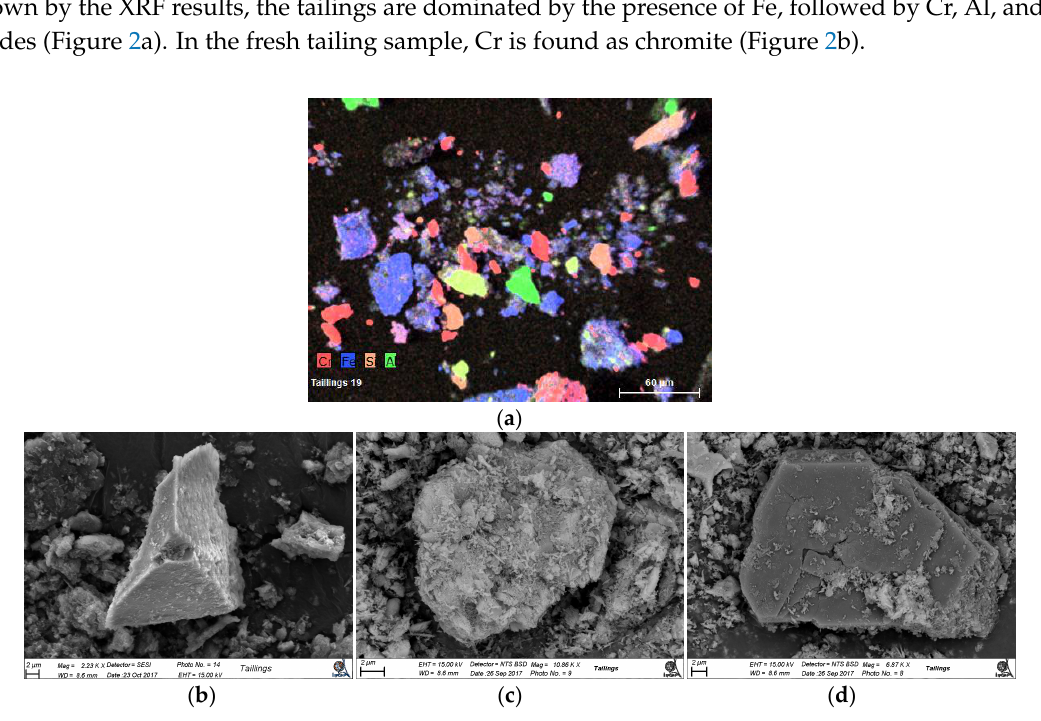
Figure 2. Chromite tailing ( a ) elementary map of EDS showing the dominance of Cr, Fe, Si, and Al. SEM images of ( b ) chromite (Cr 63 wt %), ( c ) iron oxide (Cr 9 wt %), and ( d ) aluminum oxide (Cr 6 wt %).